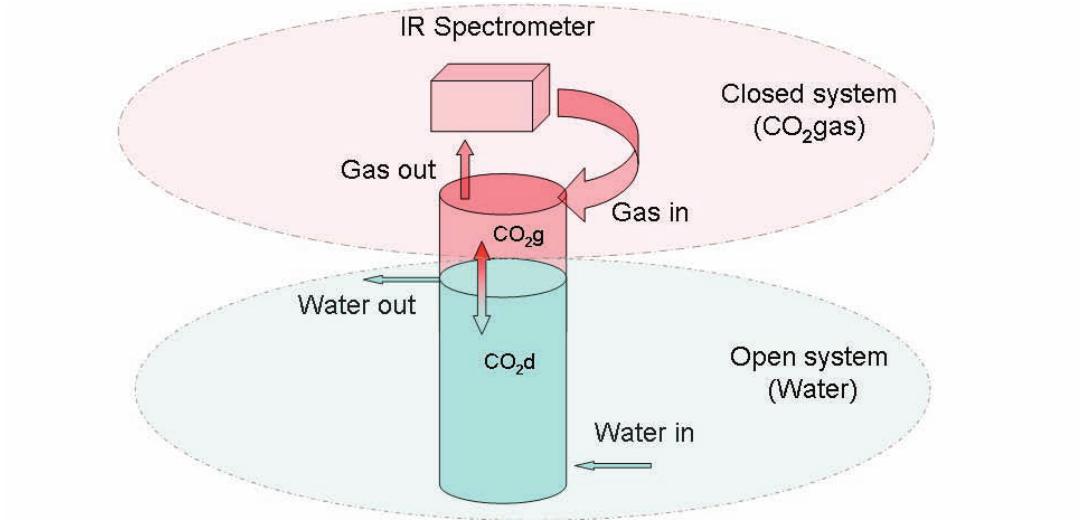
Figure 2. Schematic representation of the automated monitoring system for measuring P by a peristaltic pump that pumps the water from the well, and a closed gas system that is driven by a small gas pump that circulates the CO head-space of the equilibration chamber and the IR